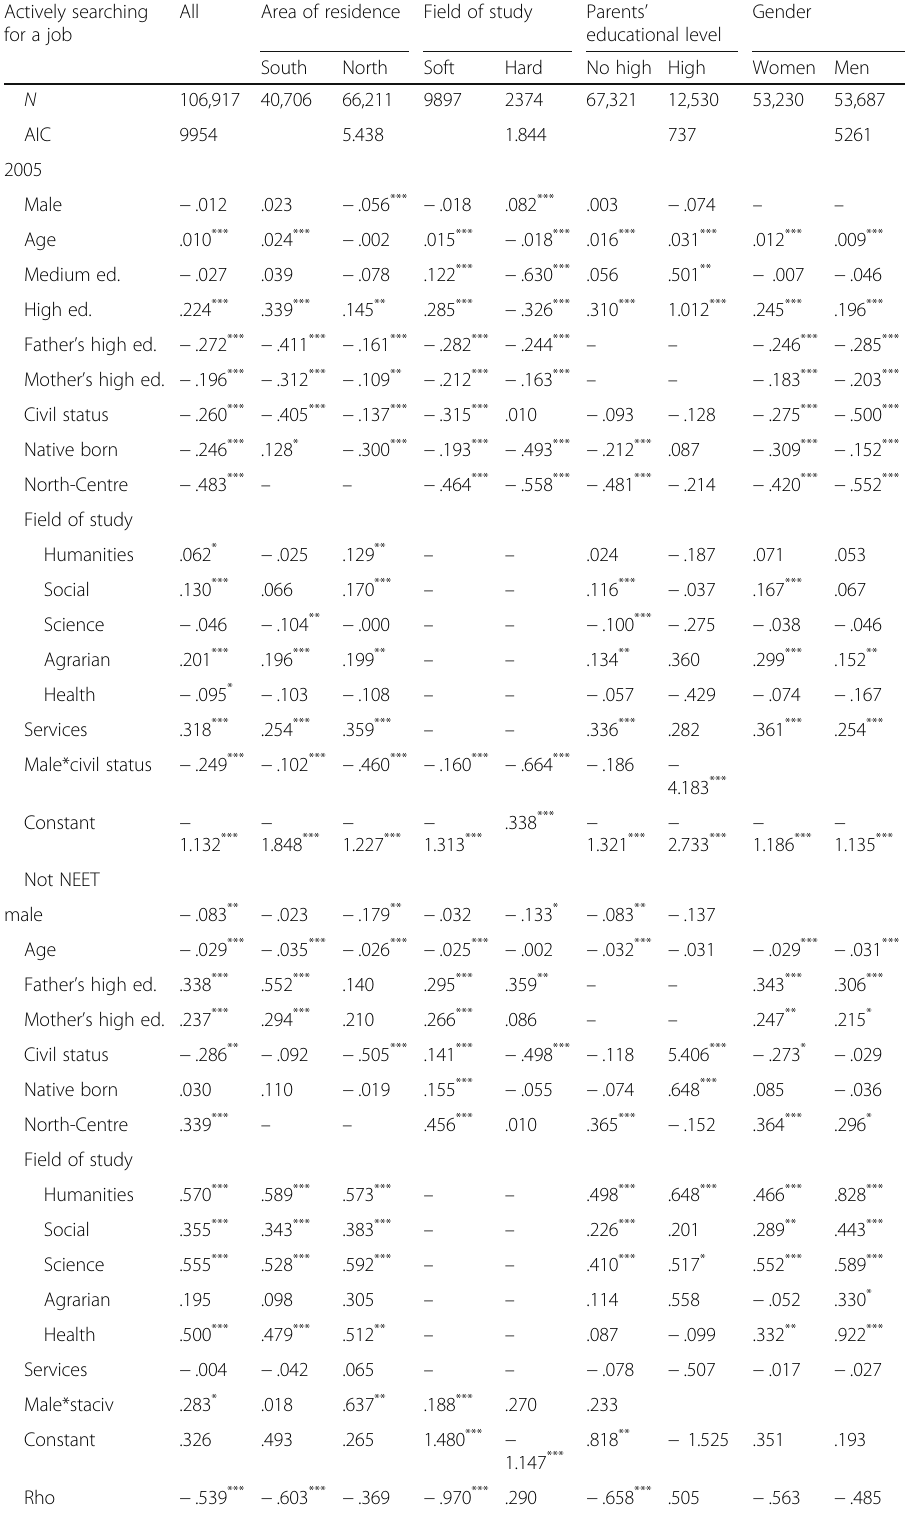
Table 4 Bivariate probit model for the probability of being not NEET and looking for a job (Continued) Actively searching for a